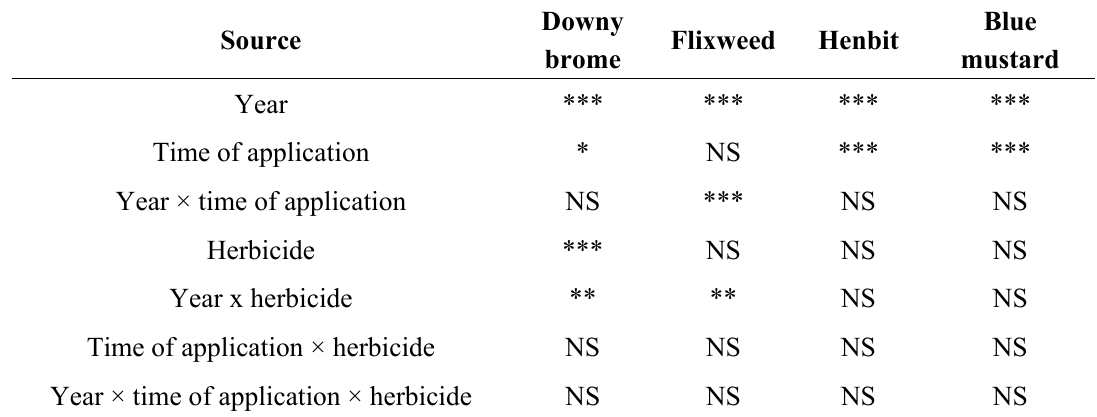
Table 2. Analysis of variance (ANOVA) results for weed control a,b . Source